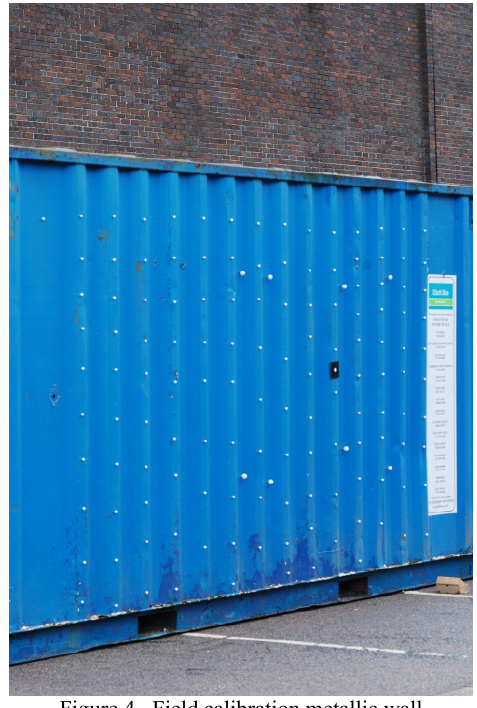
Figure 4. Field calibration metallic